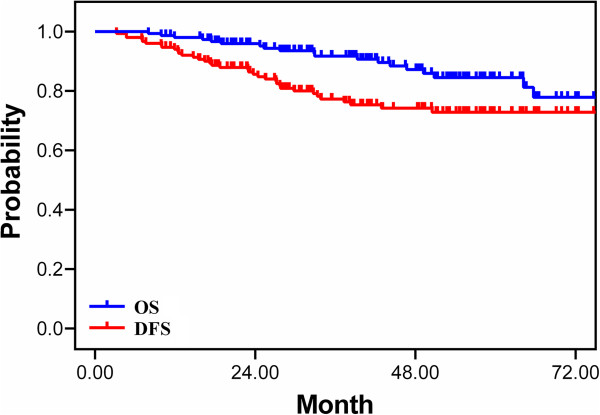
Survival curve of all patients. OS: overall survival, DFS: disease-free survival.